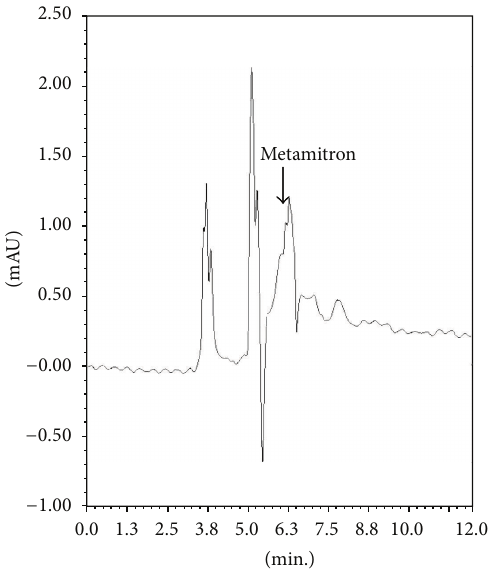
Figure 2: Chromatogram of metamitron extracted from soil after cleanup.